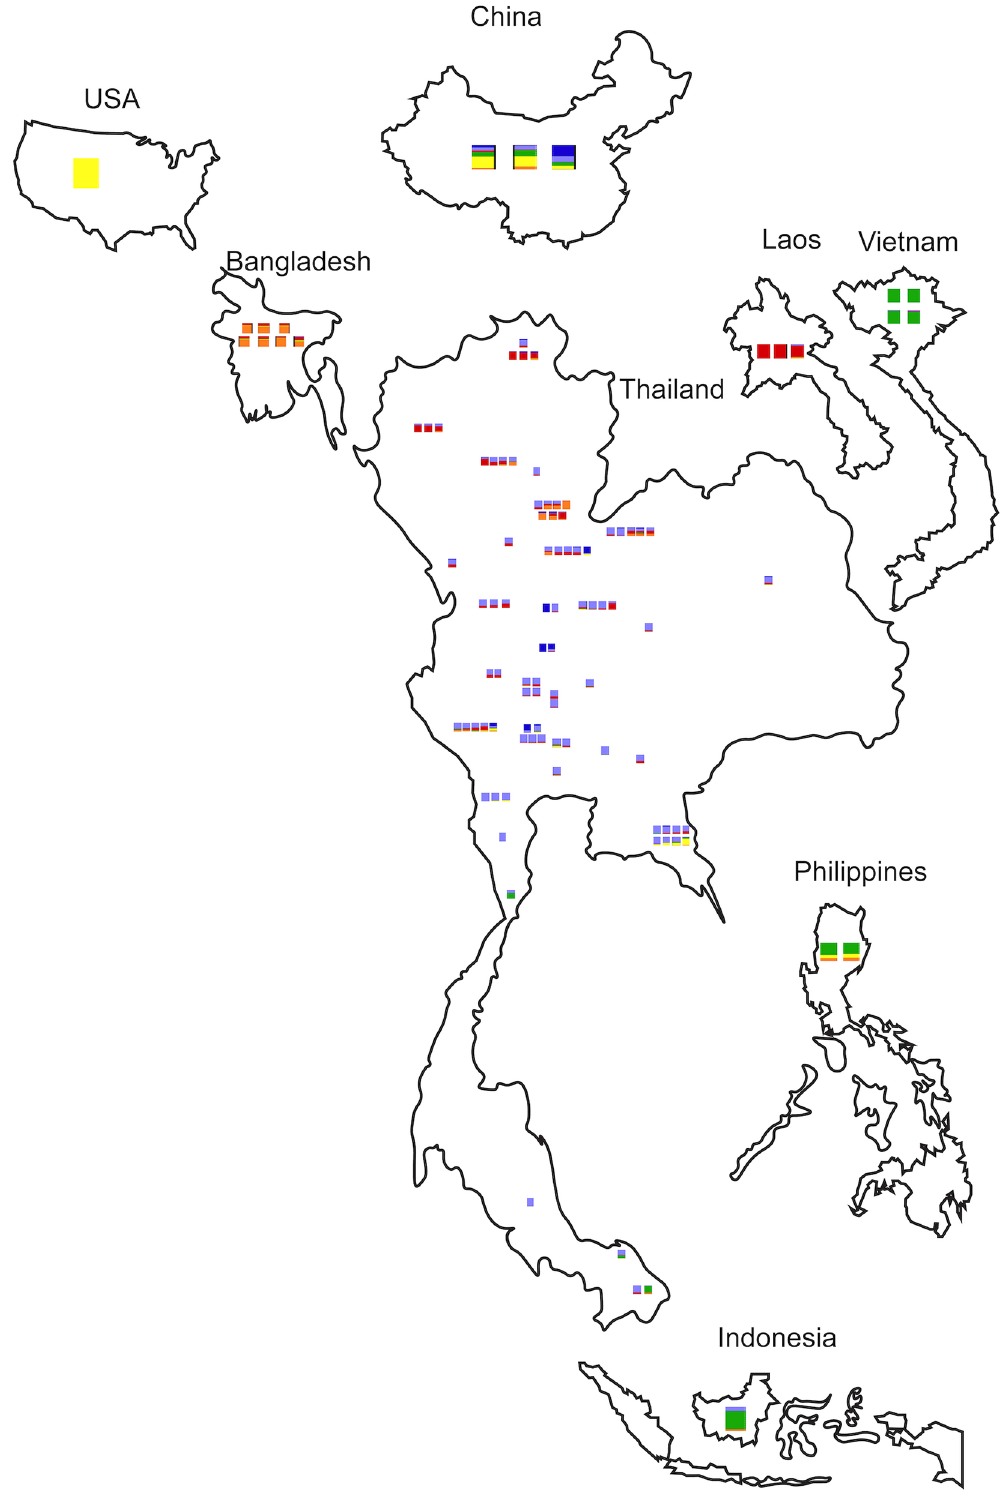
Figure 6. Distribution of Luffa acutangula accessions and their corresponding countries. Colors are based on STRU CTU RE analysis bars from Fig. 1 (Maps created in Adobe Illustrator 2021 version